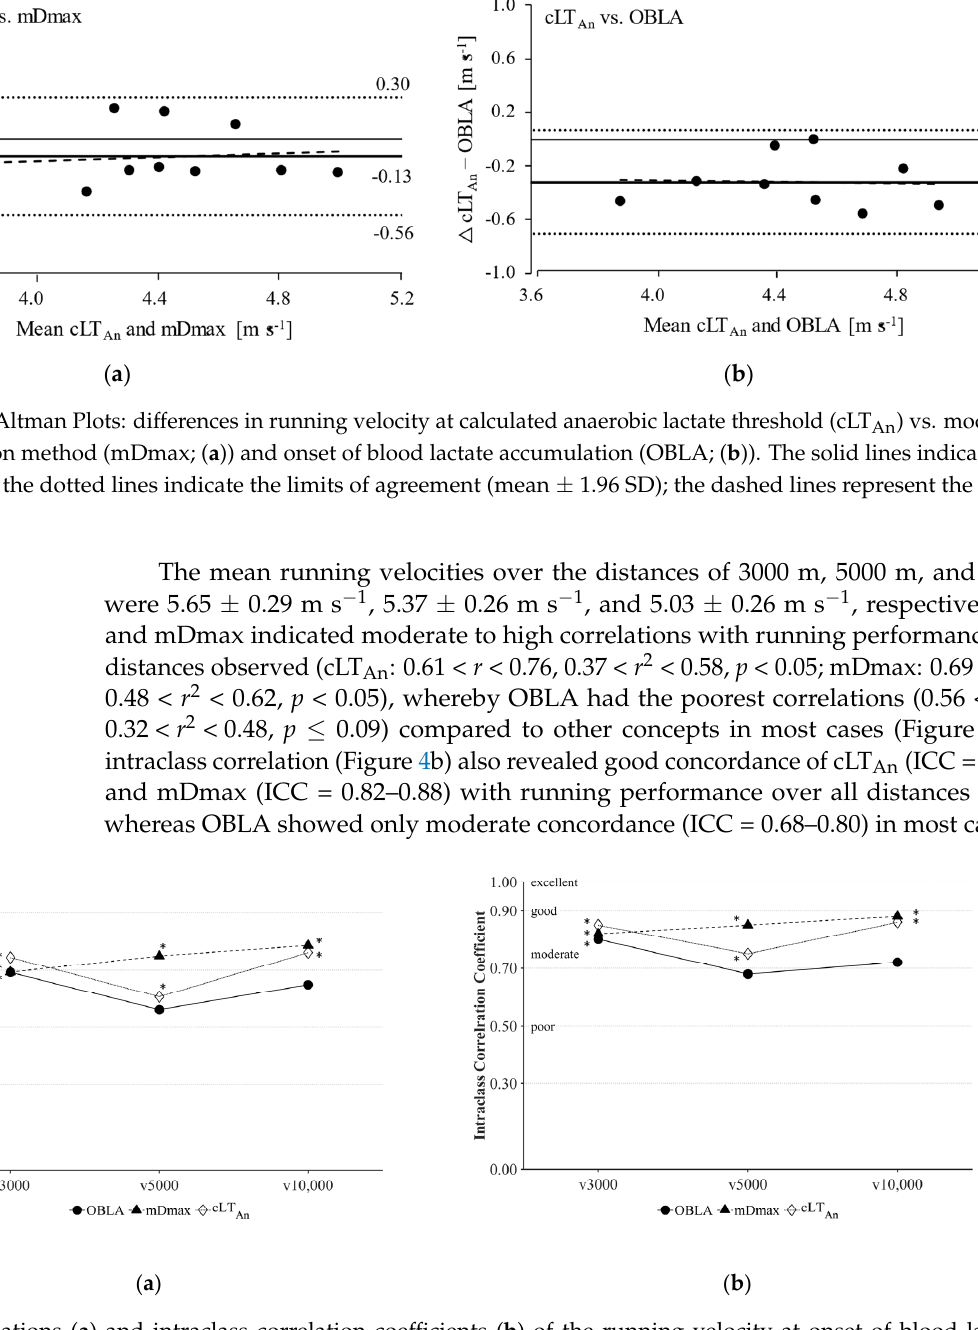
Figure 4. Correlations ( a ) and intraclass correlation coefficients ( b ) of the running velocity at onset of blood lactate accumulation (OBLA), modified maximal deviation method (mDmax), and calculated anaerobic lactate threshold (cLT An ) compared to average running velocity over 3000 m (v3000), 5000 m (v5000), and 10,000 m (v10,000); * p <